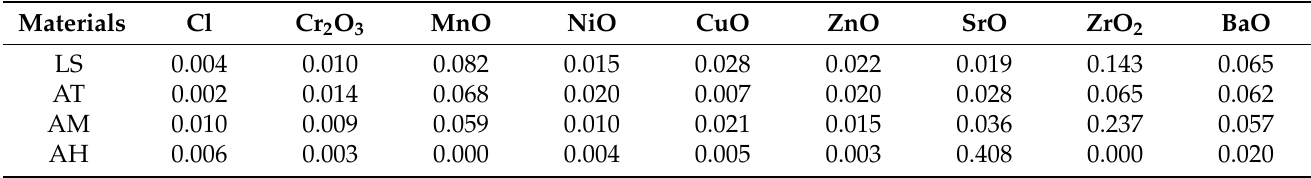
Table 2. Trace elements of raw